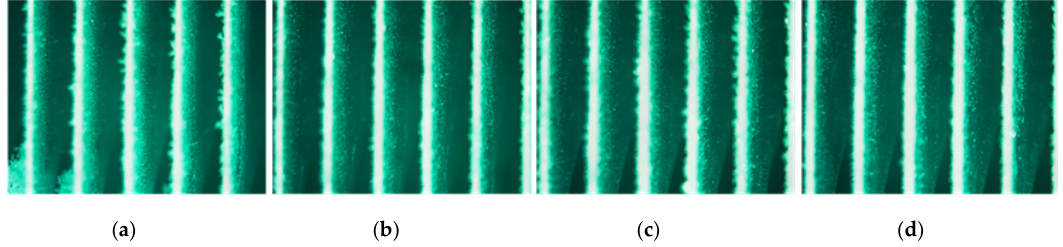
Figure 15. Microscopic images of the frost fin under the conditions of DB = 2 °C and RH = 85%. ( a ) Intermittent 50 s; ( b ) intermittent 110 s; ( c ) intermittent 170 s; ( d ) intermittent 230 s.